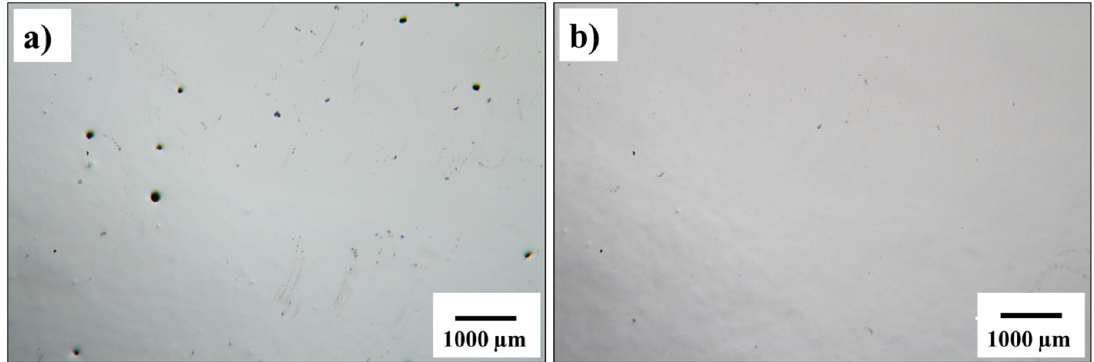
Figure 3. Porosity level in Ti‐6Al‐4V builds in the ( a ) as‐fabricated condition showing spherical pores and ( b ) post‐hot isostatic pressing (HIP) condition.